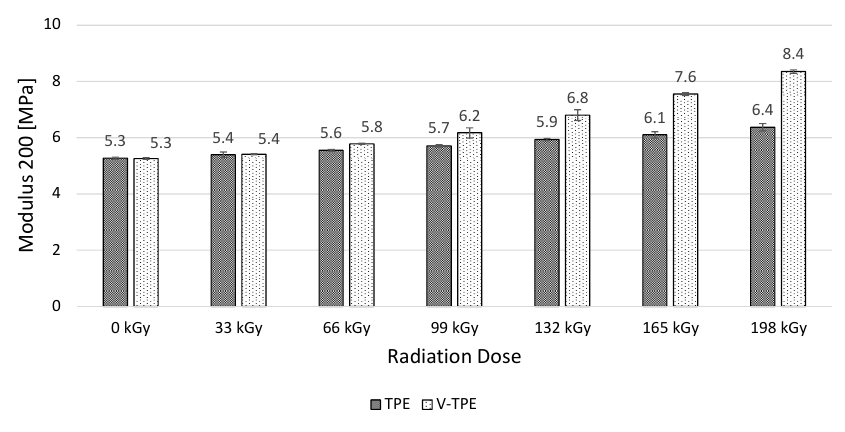
Figure 13. Modulus 200—TPE, V-TPE.